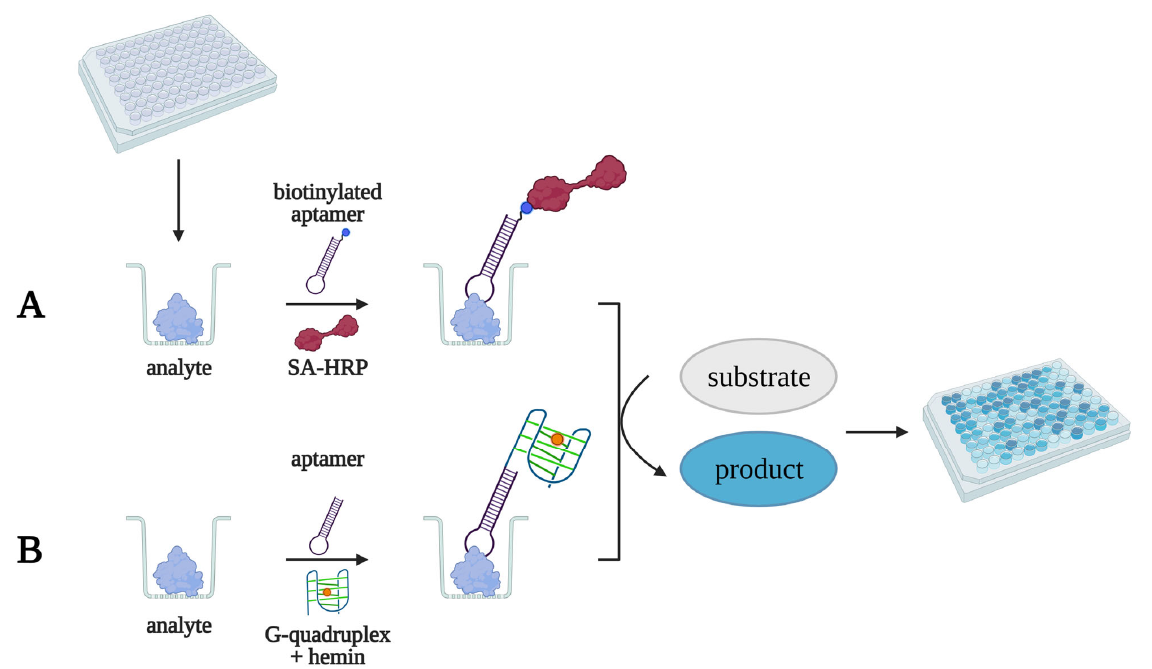
Figure 2. General scheme of detection for a colorimetric aptasensor with peroxidase ( A ) or peroxidase-like ( B ) generation of the analytical signal. First, a biotinylated aptamer forms a complex with the analyte in a microplate well; then, streptavidin-conjugated peroxidase binds biotin. Next, peroxidase ( A ) or a peroxidase-mimicking analog ( B ) oxidizes the chromogenic substrate, turning a colorless solution into a colored solution.